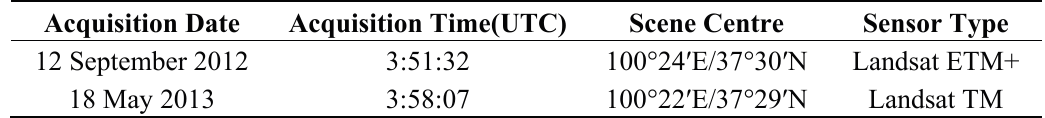
Table 4. List of the optical images collected over the study